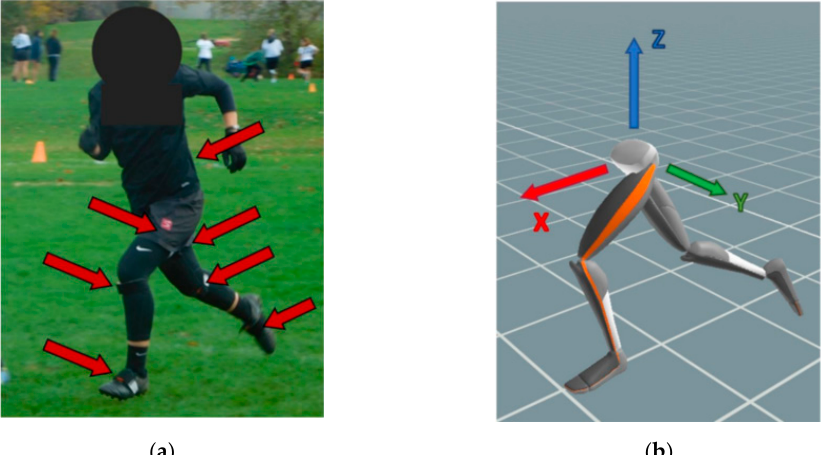
Figure 1. ( a ) shows a participant with the seven IMU sensors. ( b ) is the kinematic model created from their movement and the coordinate system defined at the start of each